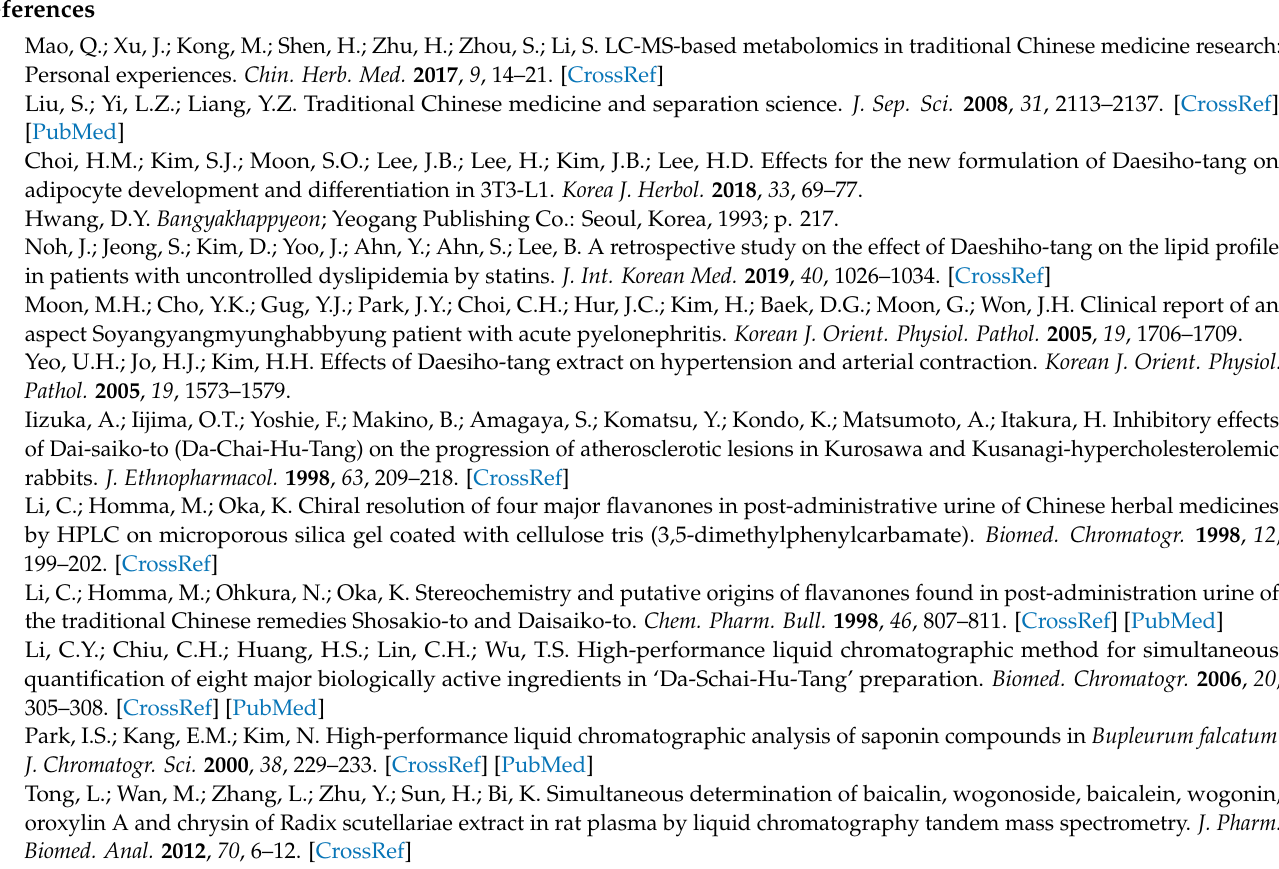
Figure S2: HPLC chromatogram of the mixed 16 standard solution (A) and the DSHT sample (B). Gallic acid ( 1 ), homogentisic acid ( 2 ), 3,4-dihydroxybenzaldehyde ( 3 ), albiflorin ( 4 ), paeoniflorin ( 5 ), naringin ( 6 ), benzoic acid ( 7 ), baicalin ( 8 ), poncirin ( 9 ), benzoylpaeoniflorin ( 10 ), wogonoside ( 11 ), baicalein ( 12 ), saikosaponin A ( 13 ), wogonin ( 14 ), chrysophanol ( 15 ), and physcion ( 16 ); Table S1: Information and composition of DSHT; Table S2: HPLC analysis conditions for simultaneous deter- mination of the 10 marker components in DSHT; Table S3: Repeatability of the retention times of the 10 markers in HPLC analysis ( n = 6); Table S4: Repeatability for peak area of the 10 markers in HPLC analysis ( n =